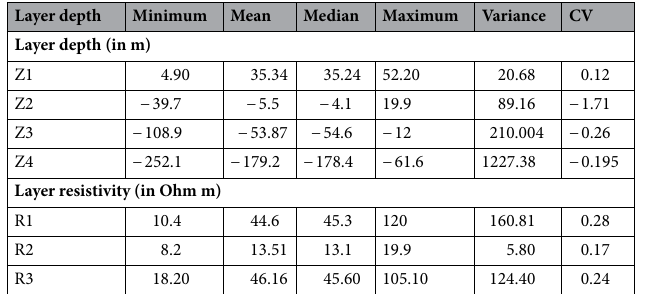
Table 1. Descriptive statistics of the cross-validation for depth of the aquifer corresponding resistivity.